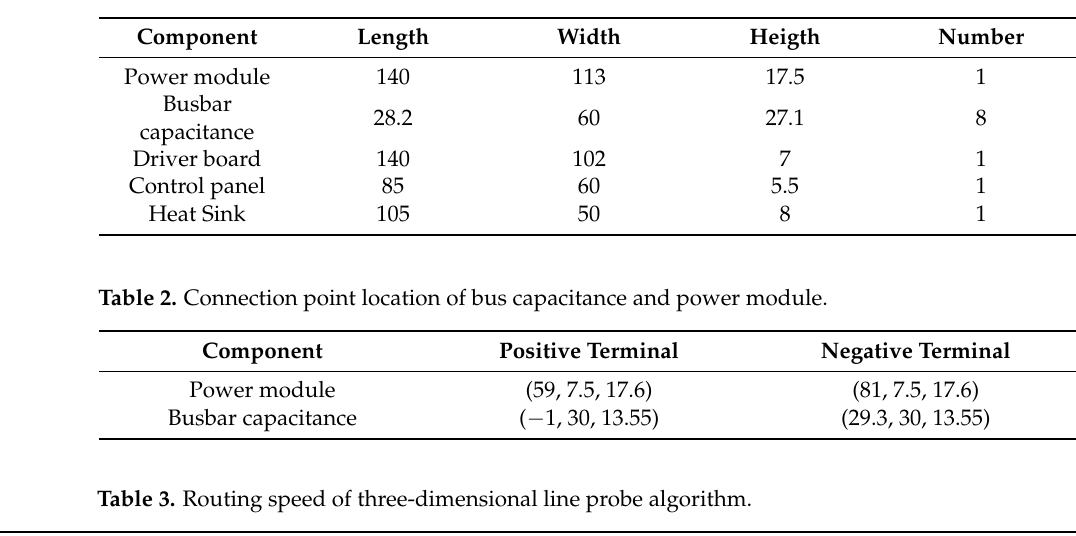
Table 1. Parameters of each component of vehicle motor drive.